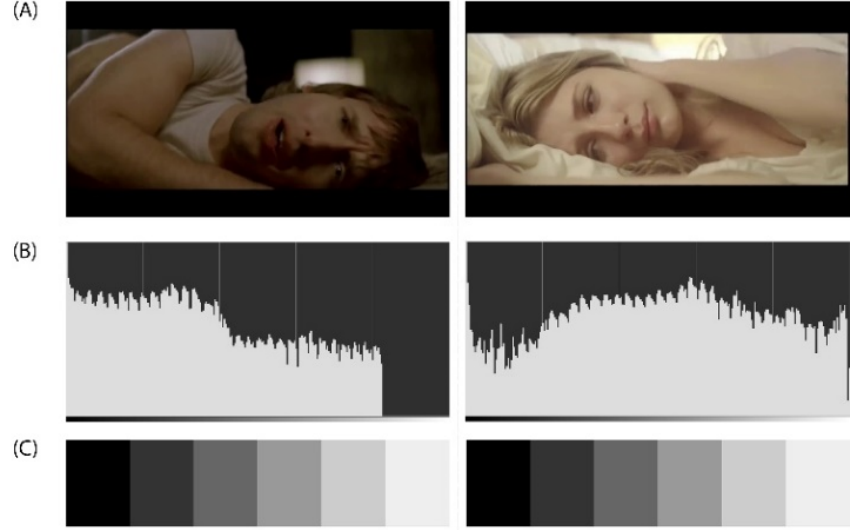
Figure A3. ( A ) DEAP Dataset Experiment_id (24) ‘Goodbye My Lover’ Music Video from James